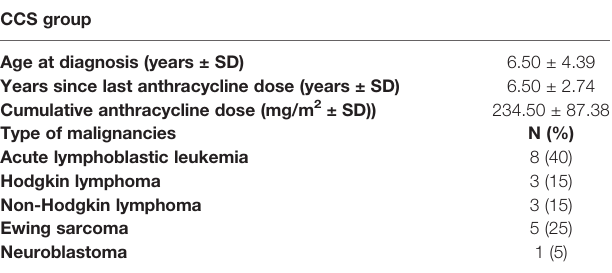
TABLE 2 | Speci fi c characteristics of CCSs